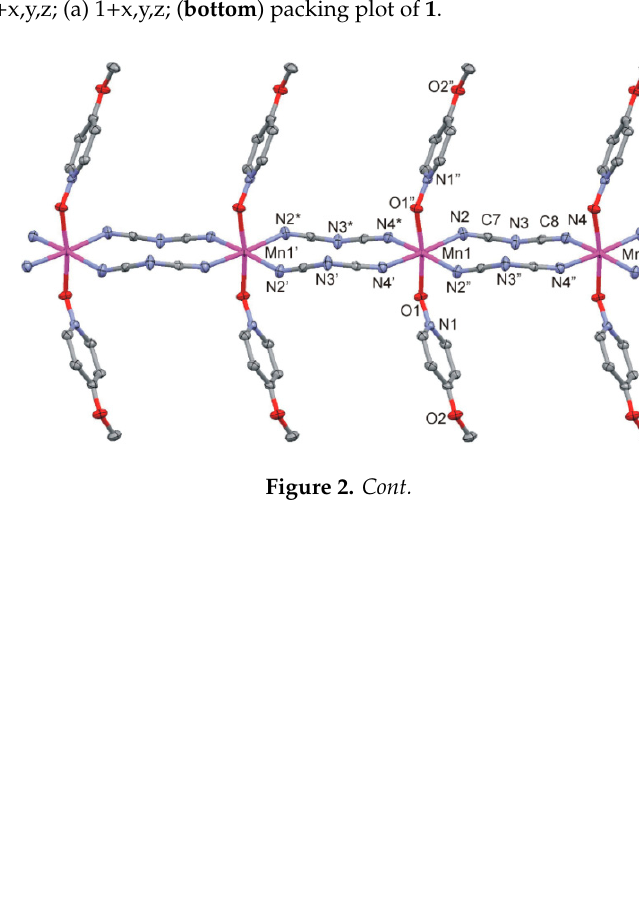
Figure 1. ( top ) One dimensional (1D) chain system of 1 . Symmetry operations: (’) 1-x,2-y,1-z; (”) 2-x,2-y,1-z; (*)-1 + x,y,z; (a) 1 + x,y,z; ( bottom ) packing plot of 1 .